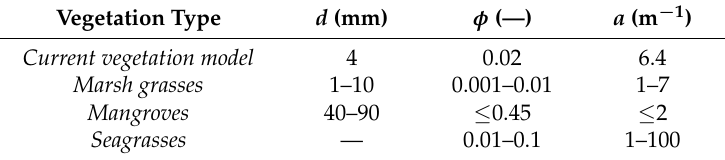
Table 1. Comparison between the current vegetation model and aquatic vegetation (from [28]).